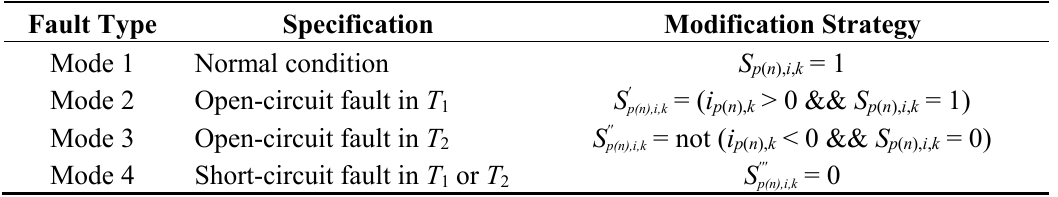
Table 6. Description of Modification